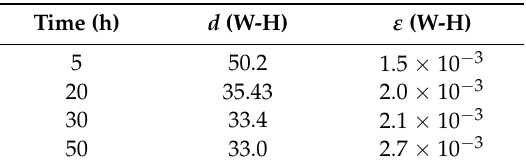
Table 2. Crystallite size (nm) and lattice strain of bulk samples as functions of milling time (h), determined by the W-H method.